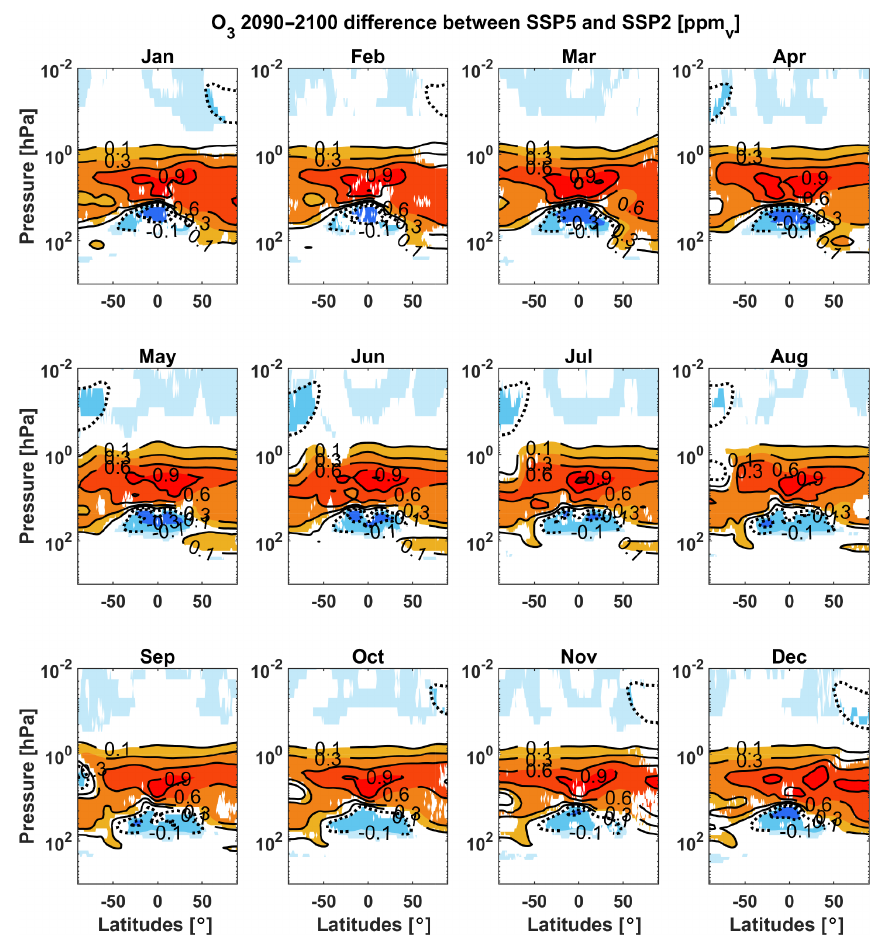
Figure 5. The difference in the monthly zonal mean ozone between SSP5 and SSP2 in ppm during 2090–2100. Positive contour levels are 0.1, 0.3, 0.6, 0.9 and 1.2ppm (solid lines), and negative contour levels are − 0 . 1 and − 0 . 3ppm (dotted lines). Colour shading indicates areas significant at the 95% level calculated with a Monte Carlo simulation and a false detection